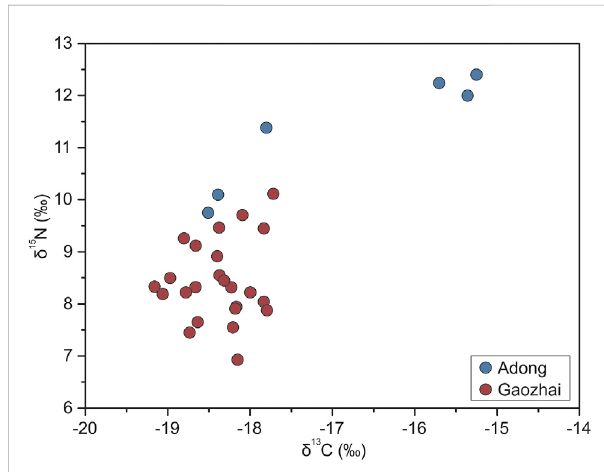
FIGURE 2 Scatter diagram of isotopic values from Gaozhai and Adong tombs.